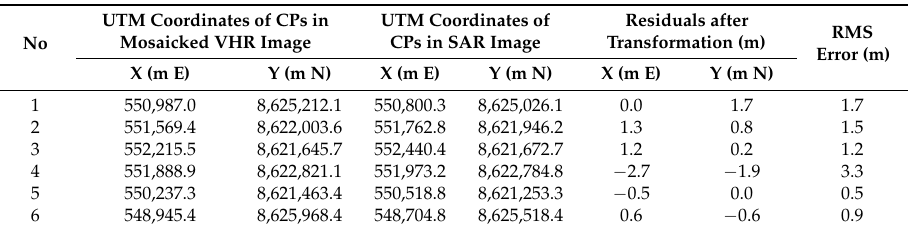
Figure 11. Comparison of the mosaicked helicopter-borne VHR image from Subset II with the TSX SAR image: ( a ) selected control points (CPs) overlaid on the SAR normalized radar cross section (NRCS) image; ( b ) the geographically registered mosaicked image overlaid on the SAR image; ( c ) zoomed area of the SAR image around the IBRV Araon; and ( d ) zoomed area of the mosaicked image around the IBRV Araon. Table 6. Results of applying the similarity transformation to the mosaicked VHR image using the selected control points (CPs).